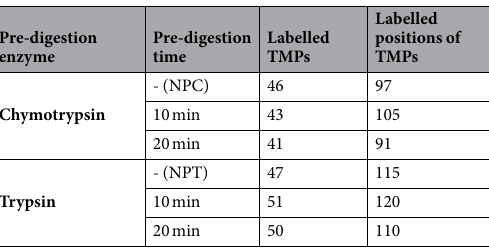
Table 2. The number of the labelled TMPs and their labelled positions under different pre-digestion conditions. The left column indicates the digestion times of the two different enzymes (NPC and NPT mark the non-pre- digested